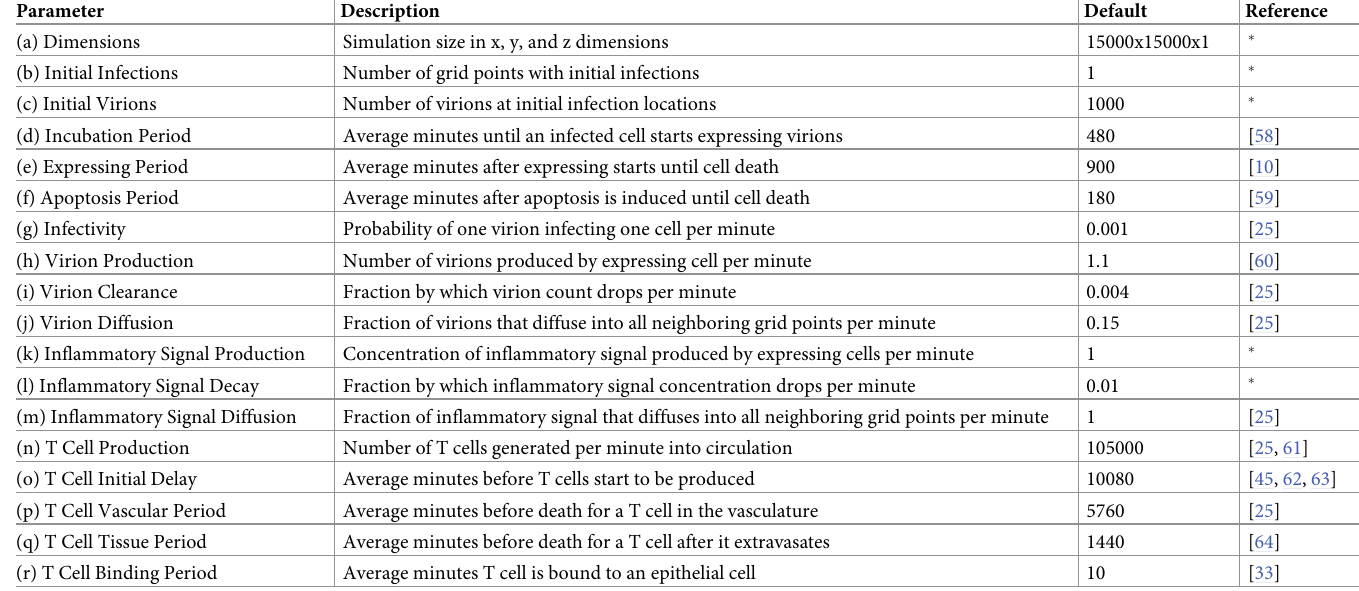
Table 2. Table of SIMCoV parameters. Default values are COVID-19 parameters assembled from a variety of sources. Time periods are Poisson distributions, defined by the mean, λ . Each time step is one minute, and grid points are five microns apart. Unless stated otherwise, the default parameters were used for all experiments. Parameters marked with ( � ) were not taken from the literature—see Parameter